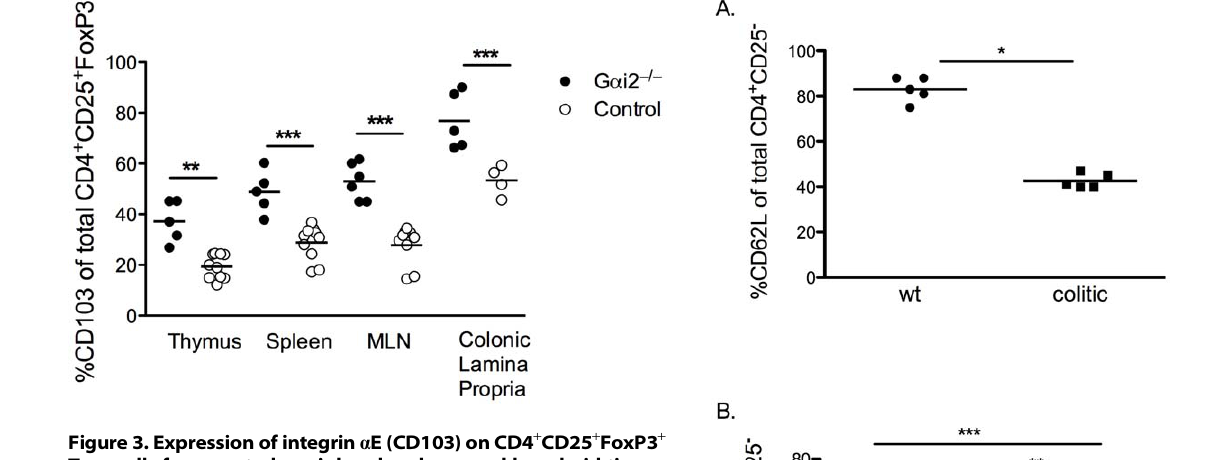
Figure 4. Increased frequencies of CD62L + and CD44 + effector T cells in spleens of G a i2 2 / 2 mice. A. Frequencies of CD62L + cells in gated CD4 + CD25 2 splenocytes in colitic G a i2 2 / 2 mice were determined by FACS analysis and compared to age-matched control mice, (n=5 in each group) B. Expression of CD44 + cells in gated CD4 + CD25 2 splenocytes in early colitic, colitic G a i2 2 / 2 mice and age-matched control mice, (n=5–6 in each group). Each symbol represents one mouse and the mean of each group is indicated by a line. Results are shown from at least three independent experiments, where *=p # 0.05, **=p # 0.01 and ***=p #